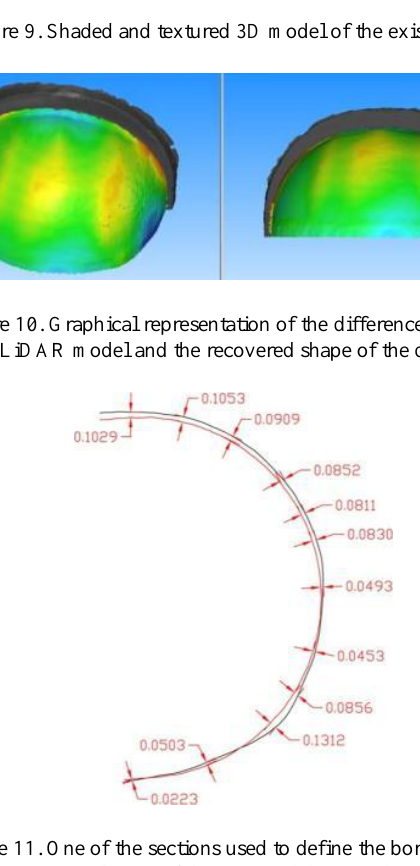
Figure 11. One of the sections used to define the borders of